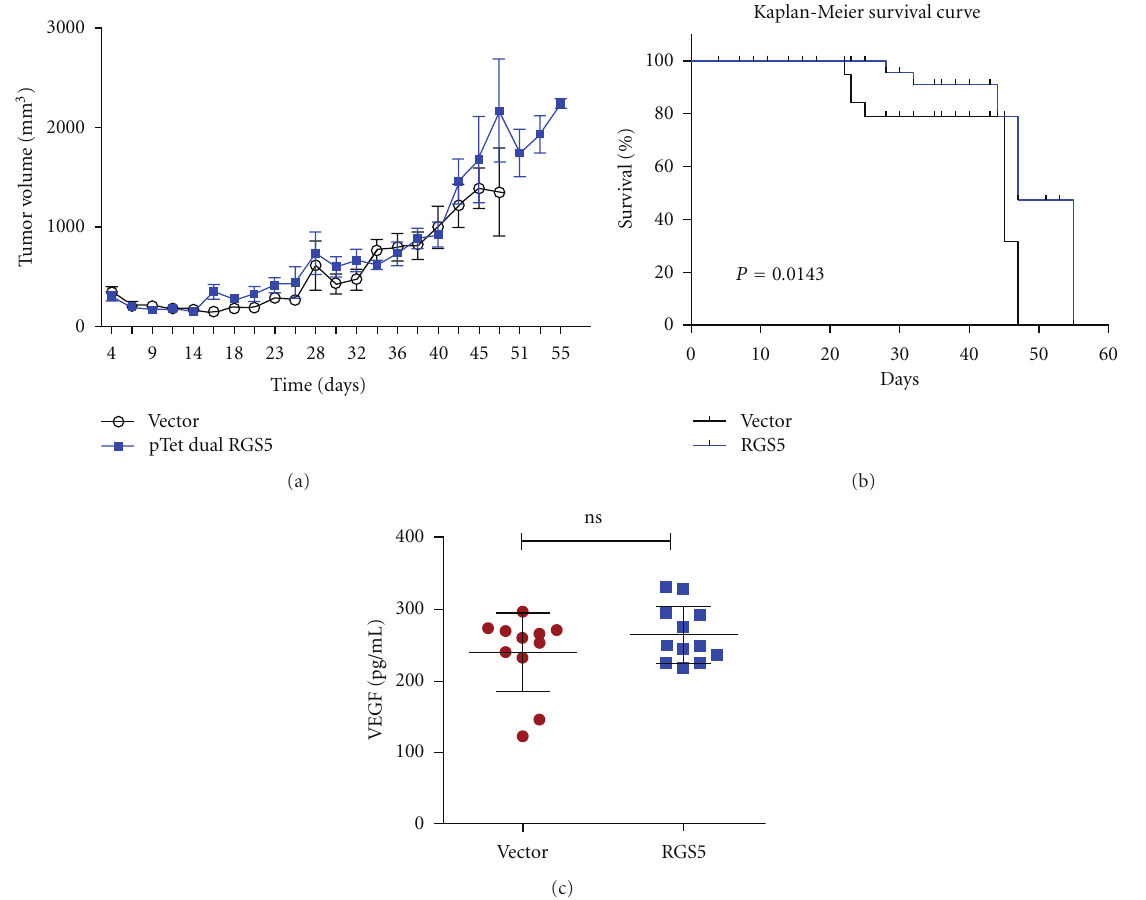
Figure 2: Expression of RGS5 in ovarian tumors did not significantly reduce the rate of growth, but did increase the overall survival time of mice bearing such tumors. (a) Female athymic nude mice were given intraperitoneal injections of Extracel containing approximately 5 million cells of either HeyA8 MDR pTet Advanced Vector ( N = 10) or HeyA8-MDR pTet Dual RGS5 expressing cells ( N = 10) per 0.2 μ L injection. All mice were monitored for tumor formation and measurements of weight and stomach circumference were routinely taken. The graph plots tumor volume (mm 3 ). (b) Mice bearing HeyA8-MDR pTet Dual RGS5-expressing tumors had a significant increase in survival time (in days, ∗ P = 0 . 0143, compared to their pTet Advanced Vector alone counterparts). (c) Blood was collected from mice at necropsy. The serum-containing fraction was isolated and measured for vascular endothelial growth factor. Results are nonsignificant (ns) between the